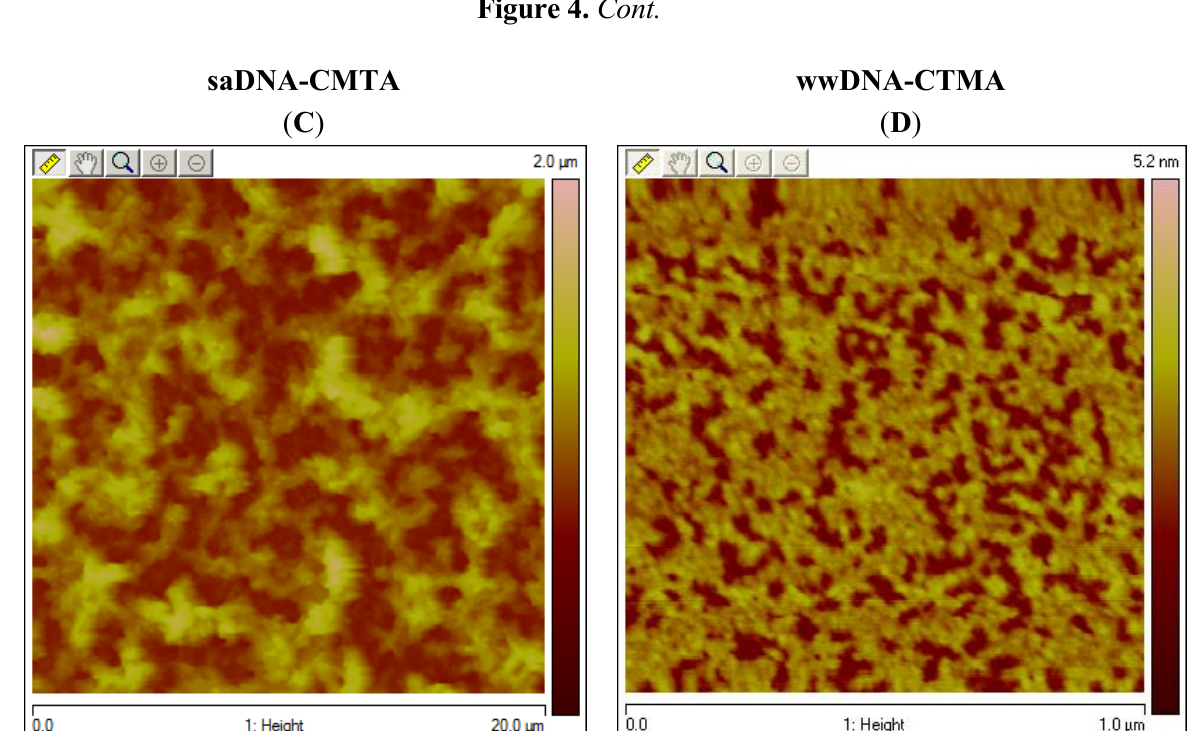
Figure 4. Cont. saDNA-CMTA